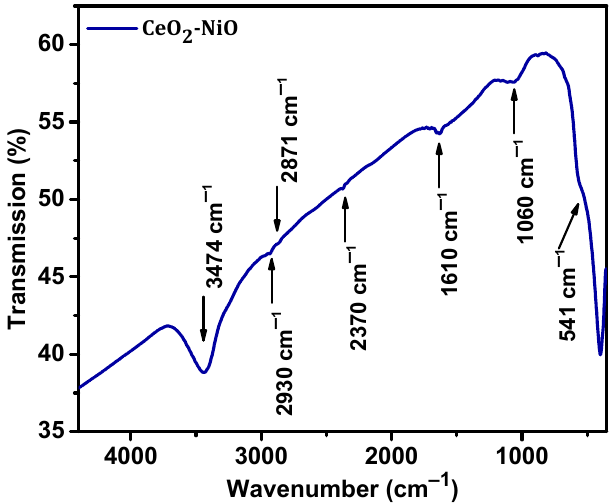
Figure 6. FTIR spectrum of CeO 2 /NiO nanocomposite. A significant peak centered at 404 cm − 1 the characteristic peak corresponding to the stretching vibration of the Ni-O bond in NiO present in this nanocomposite [25]. The same kind of observation was made by Korosec and Bukovec at a slightly higher wave number i.e., 443 cm − 1 [26]. The adjacent peak centered at 541 cm − 1 which was attributed to the characteristic stretching of the Ce-O bond and thus confirmed the presence of CeO 2 [27]. The peaks appearing at 3474 cm − 1 and 1610 cm − 1 originated from the bond